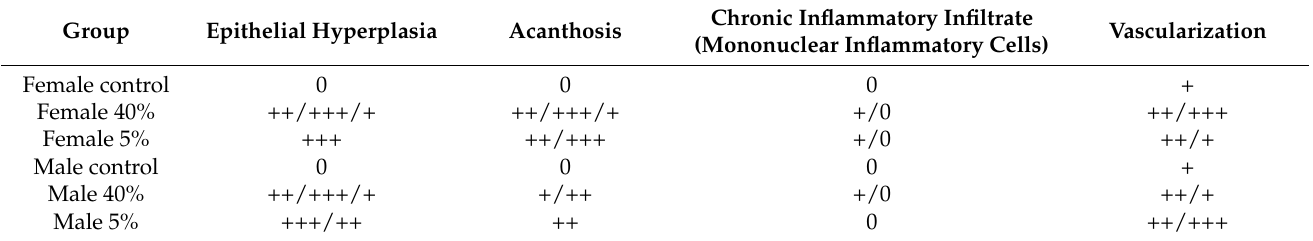
Table 4. Histological changes in the tongue of rats after weekend alcohol consumption for 3 months.